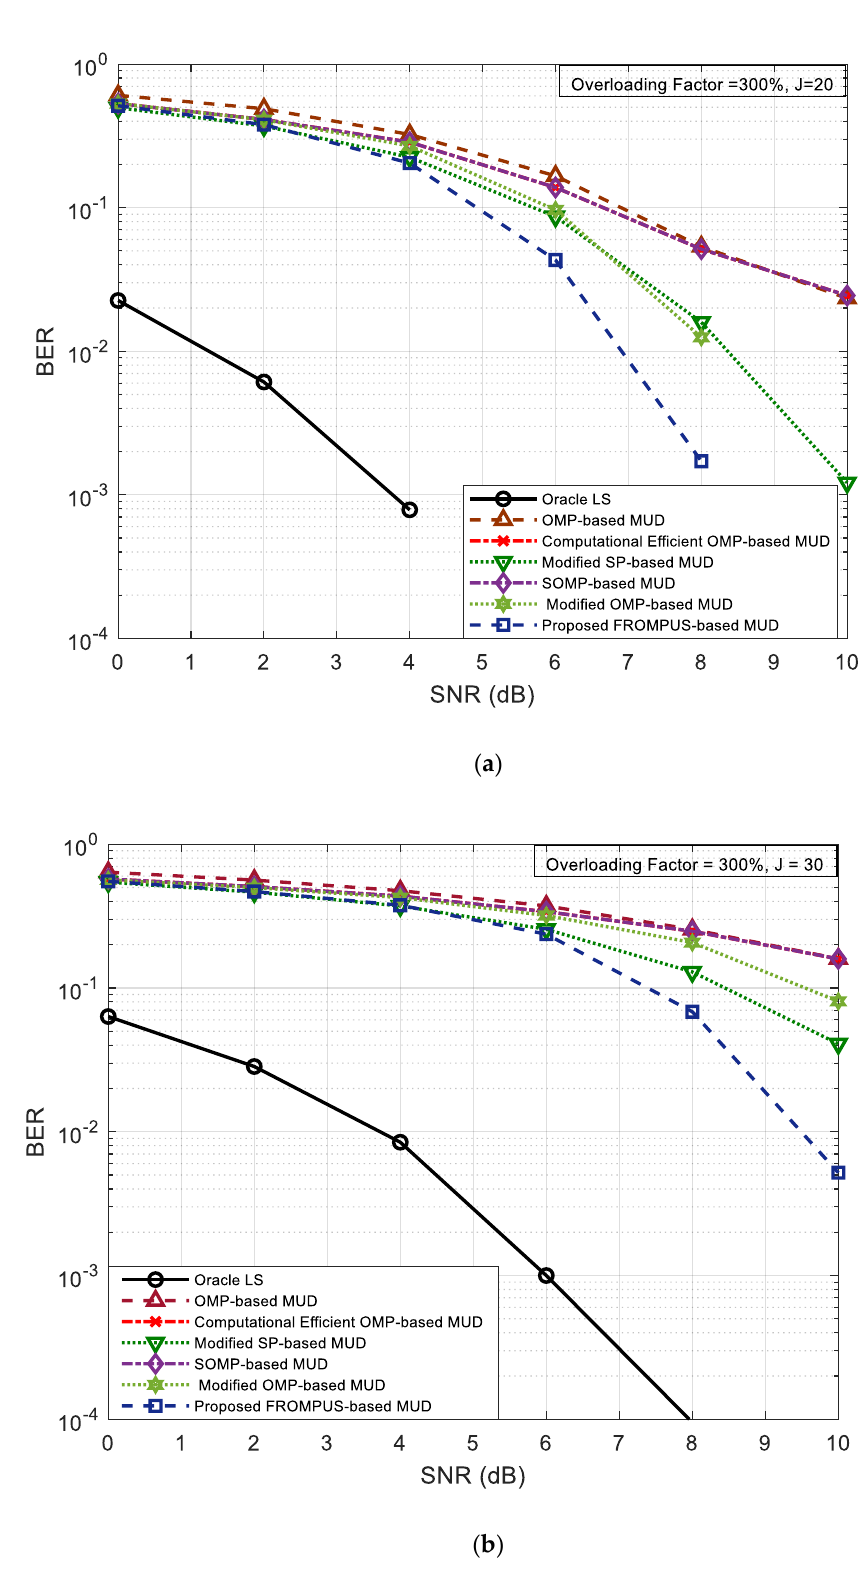
Figure 5. Achievable BER versus SNR performance of the FROMPUS-based MUD in comparison with five other MUDs, overloading factor= 300%, 𝑇 = 7 : ( a ) ℑ = 20 ; ( b ) ℑ = 30